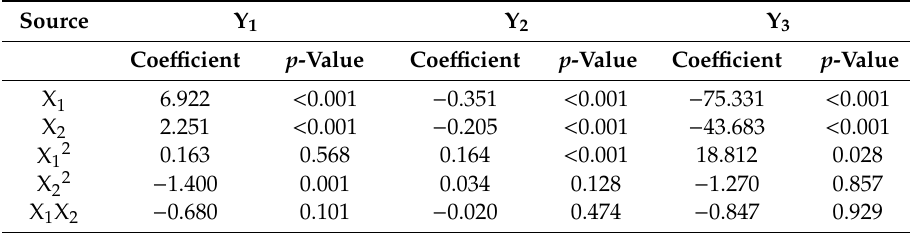
Table 4. Significance test of coe ffi cients in the regression equation.